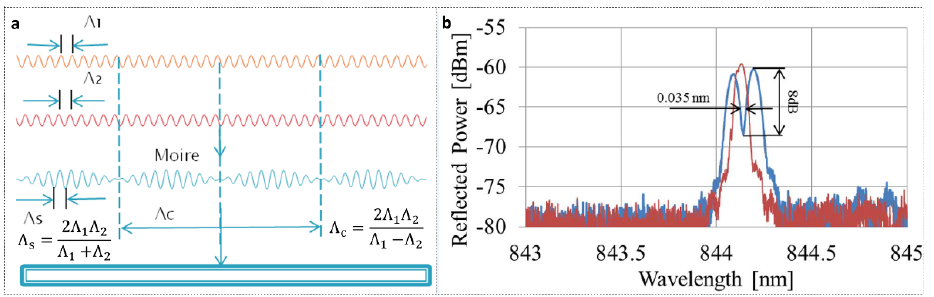
Figure 16. ( a ) Principle of Moir é grating: Λ 1 and Λ 2 represent the periods of grating 1 (orange line) and grating 2 (red line), respectively; Λ s and Λ c are obtained by superimposing grating 1 and grating 2 (blue line). Reprinted with permission from [76]. ( b ) Reflected amplitude spectra of first uniform FBG (red line) and FSFBG (blue line). Reprinted with permission from [76].